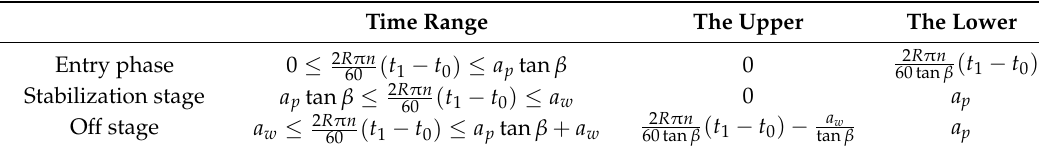
Table A1. The integral upper and lower limits of a cutter